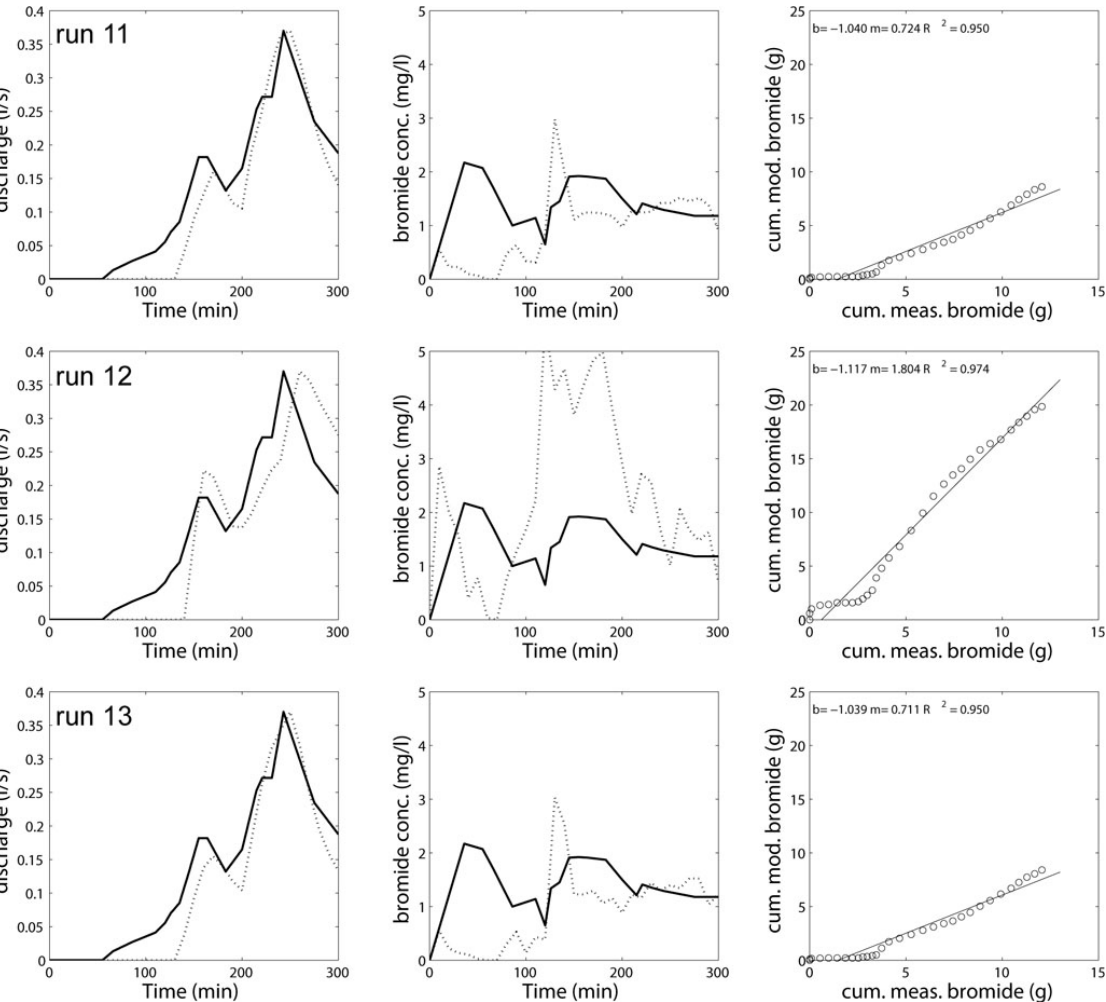
Fig. 5. The left column presents the observed discharge (solid line) and the modelled discharge (dotted line), the centre column presents the observed (solid line) and modelled (dotted line) bromide concentrations in the tile drain, while the right column presents the cumulated modelled bromide outflow versus the measured one and a linear regression line between them (b denotes the intersect and m the slope of the regression). The runs 11 to 13 are shown